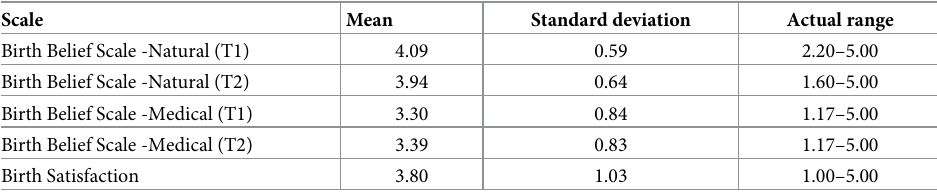
Descriptive statistics for the study variables are presented in Table 2. It is noticeable that in both timepoints, BBS-Natural had a higher mean and smaller standard deviation than the BBS-Medical indicating that women tended to view birth as a natural process, with more vari- ance regarding birth as a medical process. The Actual Birth and Birth Satisfaction also had great variability. The most common Actual Birth was VD with epidural ( n = 142, 41%), fol- lowed by instrumental birth ( n = 64, 19%), emergency CD ( n = 40, 12%), and VD without epi- dural in a regular delivery room ( n = 38, 11%). Fewer women had an elective CD ( n = 26, 8%), home birth ( n = 19, 5%) or birth in a natural birth center ( n = 13, 4%). Intercorrelation between study variables are presented in Table 3. The findings indicate that prenatal and postpartum BBS-Natural are positively correlated with Actual birth and with Birth Satisfaction. In other words, stronger beliefs about birth as a natural process were associ- ated with a more natural objective delivery and with a more positive subjective birth experi- ence. On the other hand, prenatal and postpartum BBS-Medical were negatively correlated with Actual Birth and with Birth Satisfaction. In other words, stronger beliefs that birth is a medical process were associated with a more medicalized objective birth and with a less satisfy- ing subjective experience. As can be seen, the associations between prenatal and comparable postpartum beliefs were strong ( r = 0.63 and r = 0.78, respectively for the Natural and the Medical beliefs). Yet, when conducting a Students’ t -test for paired variables, on average, women’s postpartum Table 2. Descriptive statistics of the main study